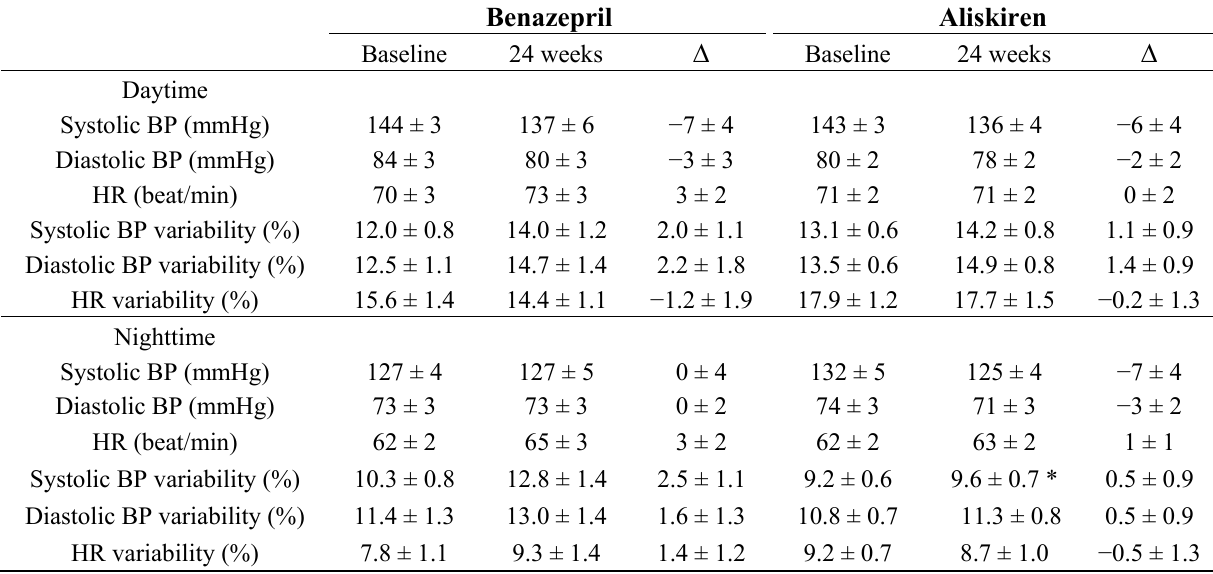
Table 4. Ambulatory BP and HR profile before and after add-on anti-hypertensive